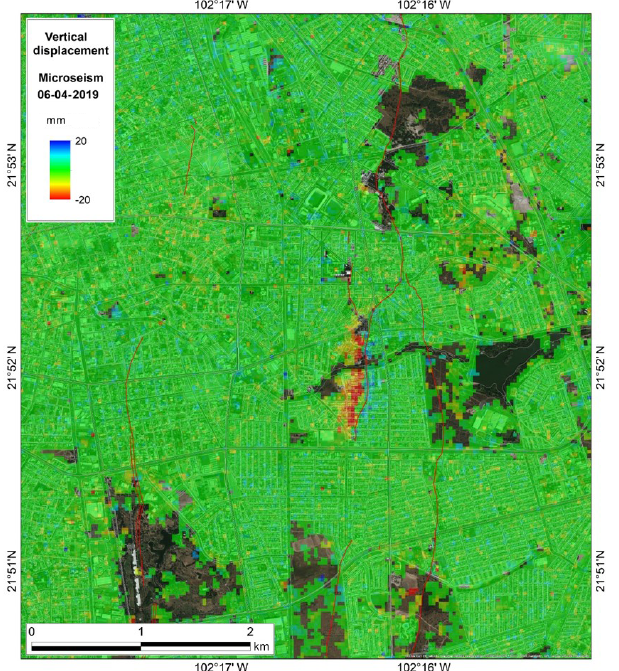
Figure 3. Vertical displacement recorded with PSI associated to the microseism of 6 April 2019. Bar scale is in millimeters. Red lines indicate the location of discontinuities. This figure was supported by the © Google Earth software.